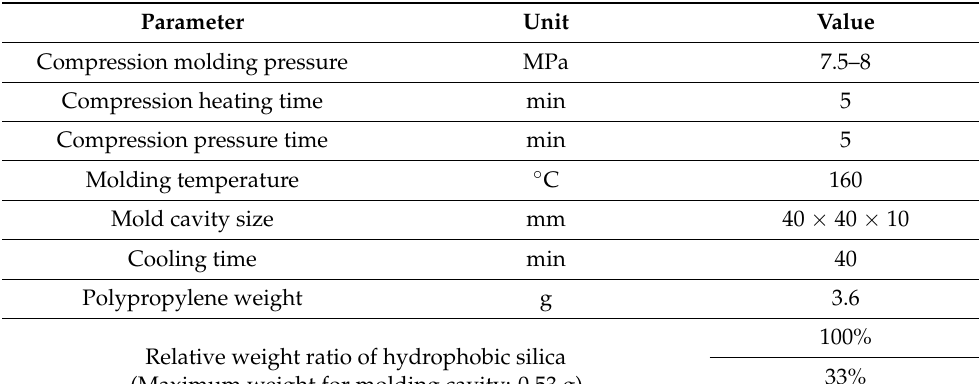
Figure 2. Images of materials and the fabricated PP/SNPs coated films. Table 1. Process parameters for compression molding with hydrophobic SNPs on